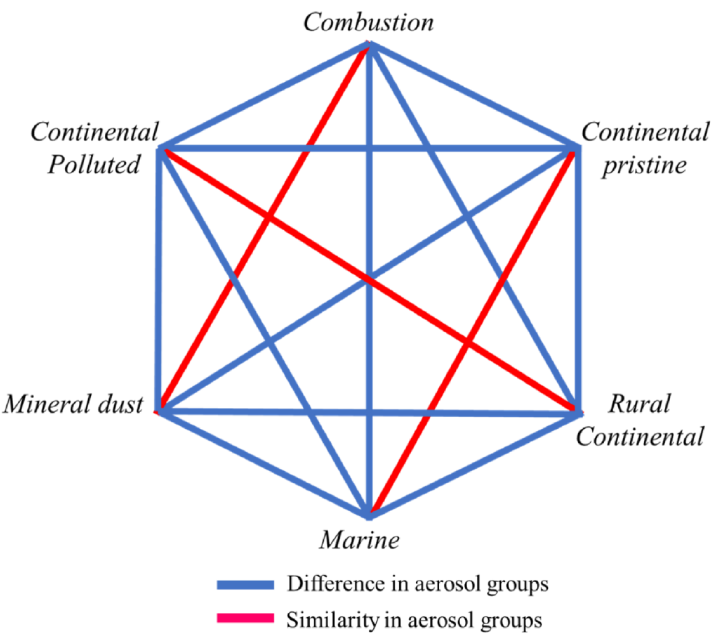
Figure A1. Web chart showing difference and similarity in INP concentrations among the six aerosol samples (Sect. 2.1) at − 15 ◦ C cold- stage temperature. Red lines show no statistically significant difference. Statistically significant differences for pairs of aerosol samples are shown by blue lines.